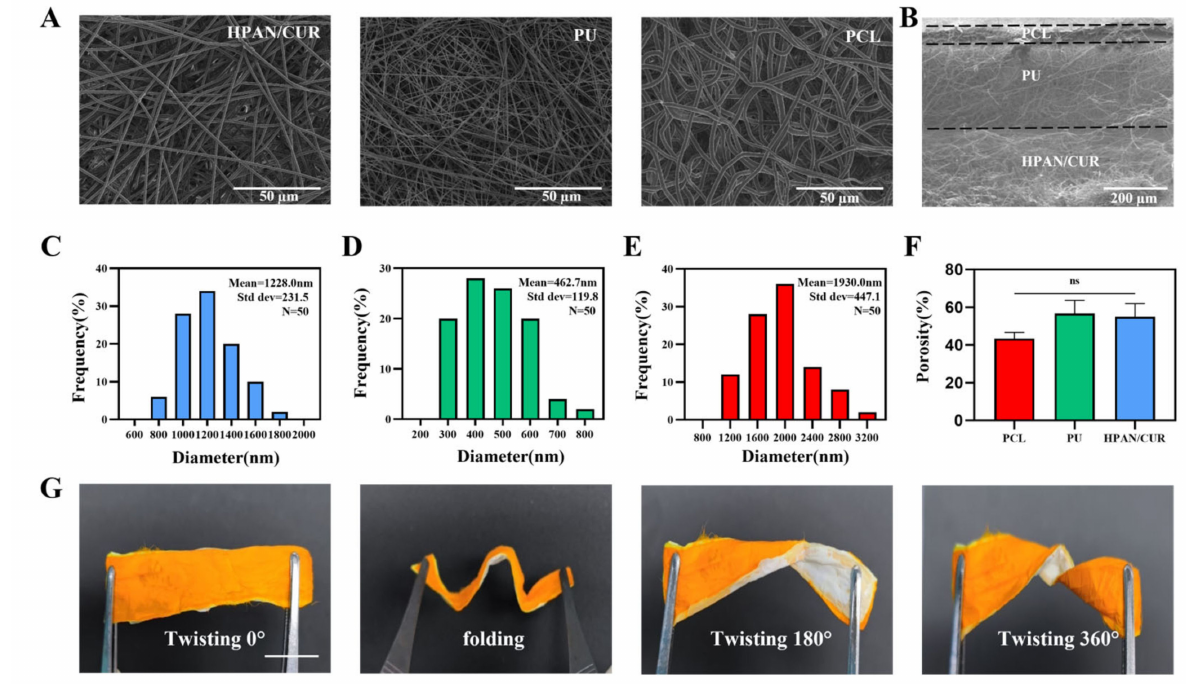
Figure 1. ( A ) SEM images of HPAN/CUR, PU, and PCL. ( B ) SEM images of Cross section. ( C – E ) The distribution of fiber diameter HPAN/CUR, PU, and PCL. ( F ) The Porosity of PCL, PU, and HPAN/CUR. ( n = 3, ns = no significance) ( G ) The photographs of dressing with different degrees of twisting. Scale bars are 1 cm in